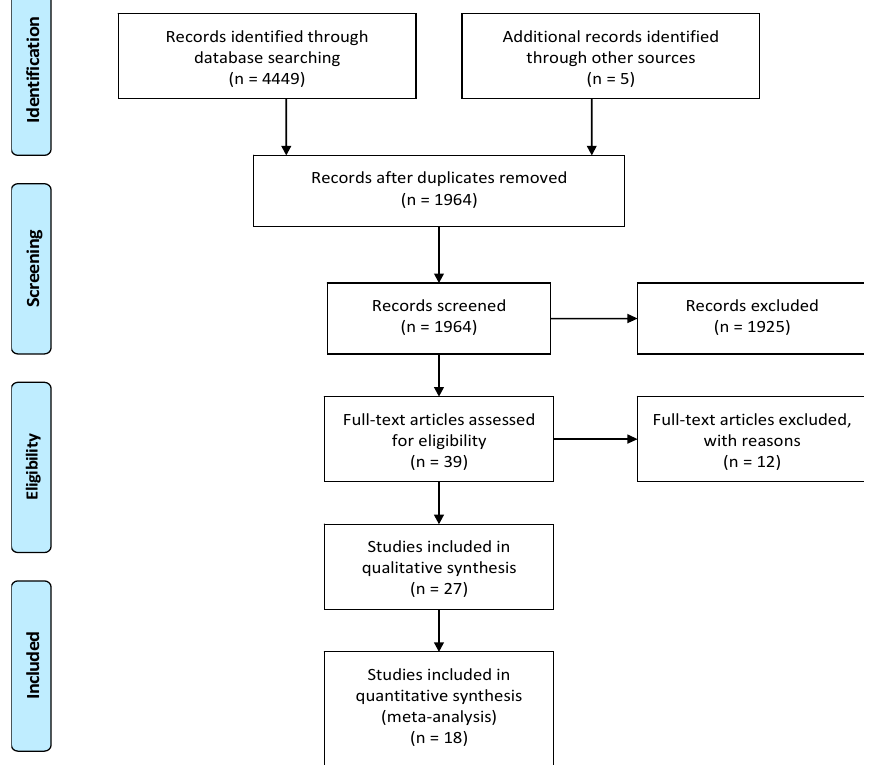
Figure 1. Preferred Reporting Items for Systematic Reviews and Meta-Analyses (PRISMA) flow-chart.